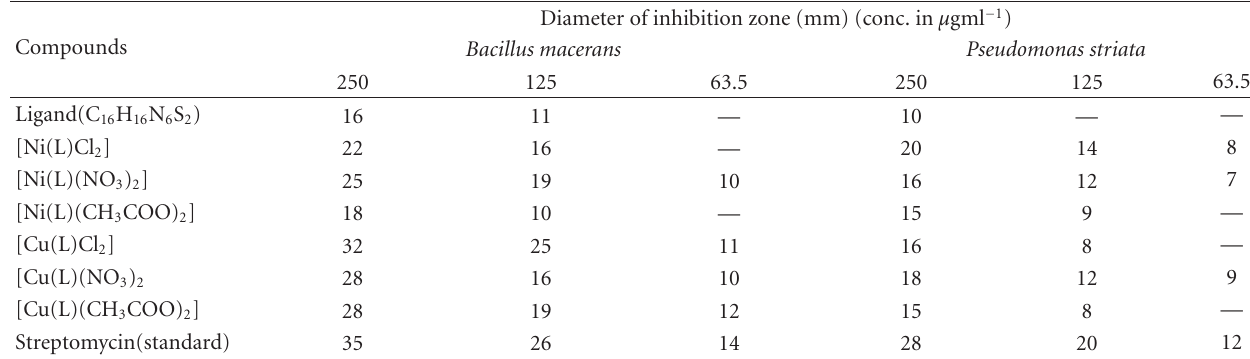
Table 5: Antibacterial screening data of the ligand and its Ni(II) and Cu(II) complexes.